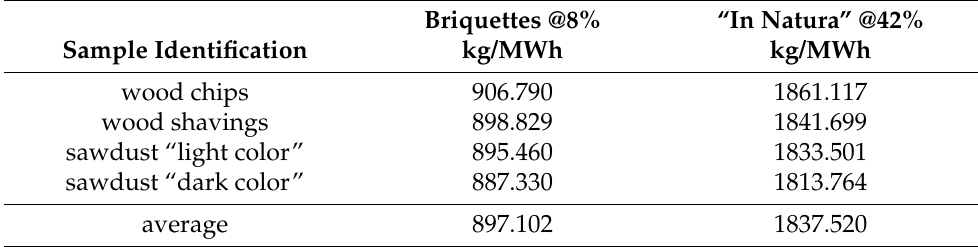
Table 8. Comparison of the energy performance of the briquettes against “in natura” material.